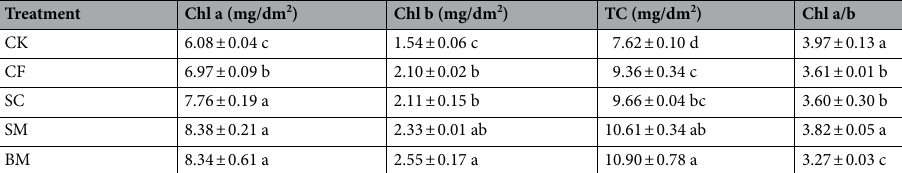
Table 3. Effects of different fertilizer treatments on chlorophyll contents of Pear-jujube. The data are the mean ± standard deviation of the parameters in this group. At different levels, each population mean follows a normal distribution with the same variance. The least significant difference (LSD) method was selected for analysis of variance in DPS software. Different lowercase letters in the same column indicate significant difference between treatments ( P < 0.05). TC Total